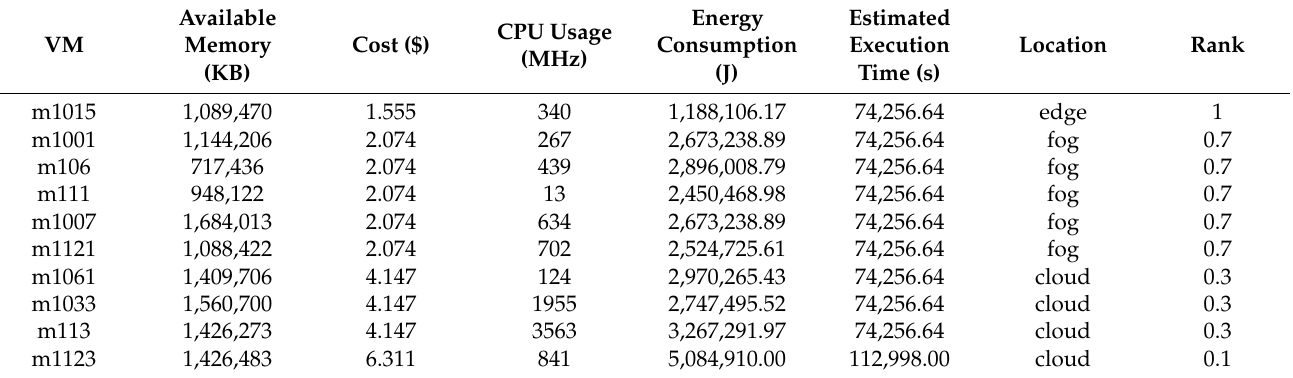
Table 15. Optimization results Task 318037 for a cost-driven use case with weights: w − MA = 0,